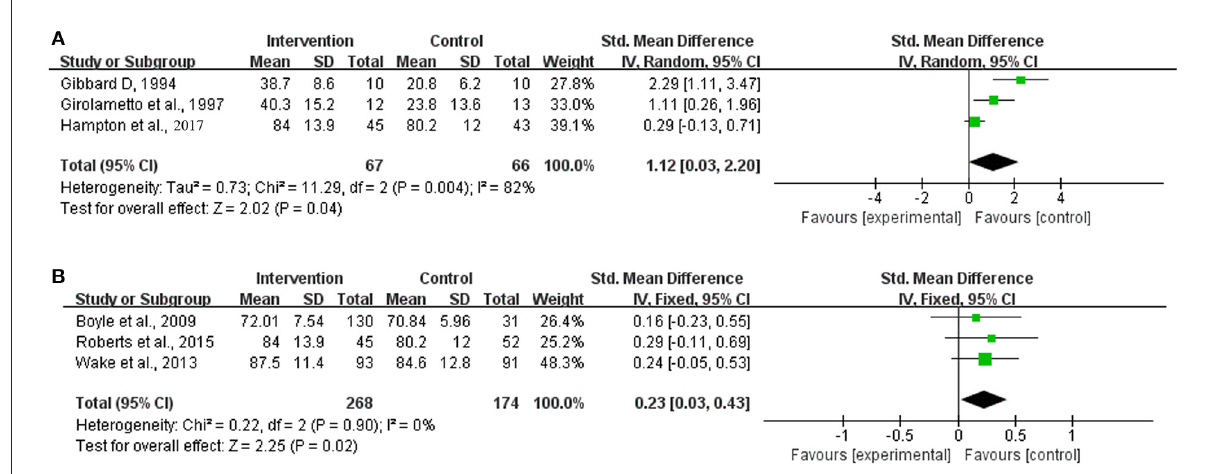
FIGURE5 Meta-analysis outcomes of the effect of the parent-guided intervention and non-parent-guided intervention on overall expressive language development. (A) Parent-guided intervention; (B) Non-parent-guided intervention. Control, no or delayed intervention.